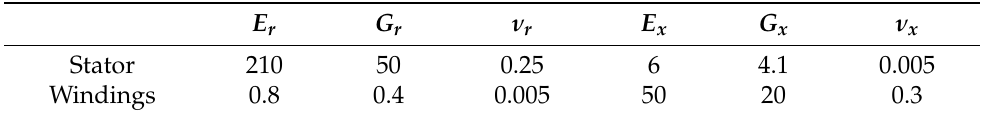
Table 1. Material properties of the stator and the windings (Elasticity and shear moduli ( E r , E x , G r , and G x ) are given in GPa).